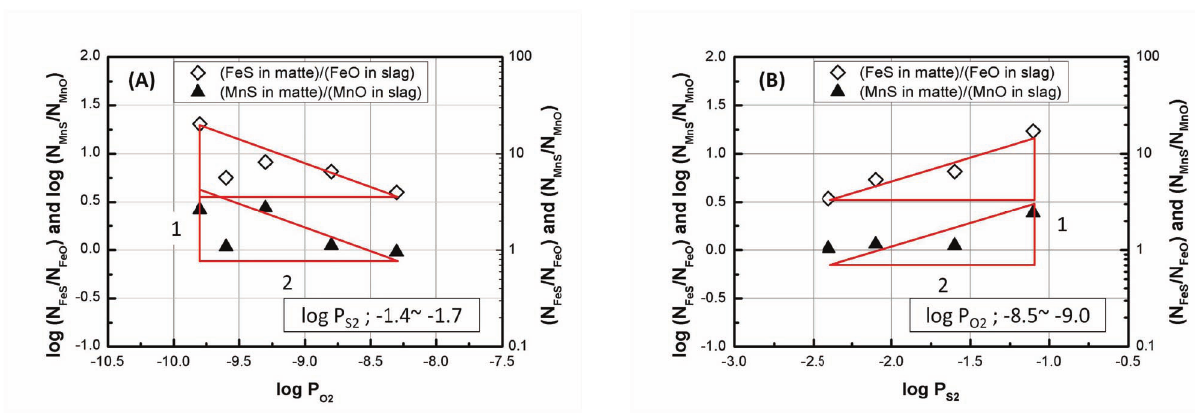
(A) and P S (B) with logarithmic mole fraction ratios of Fe and Mn between 2 2